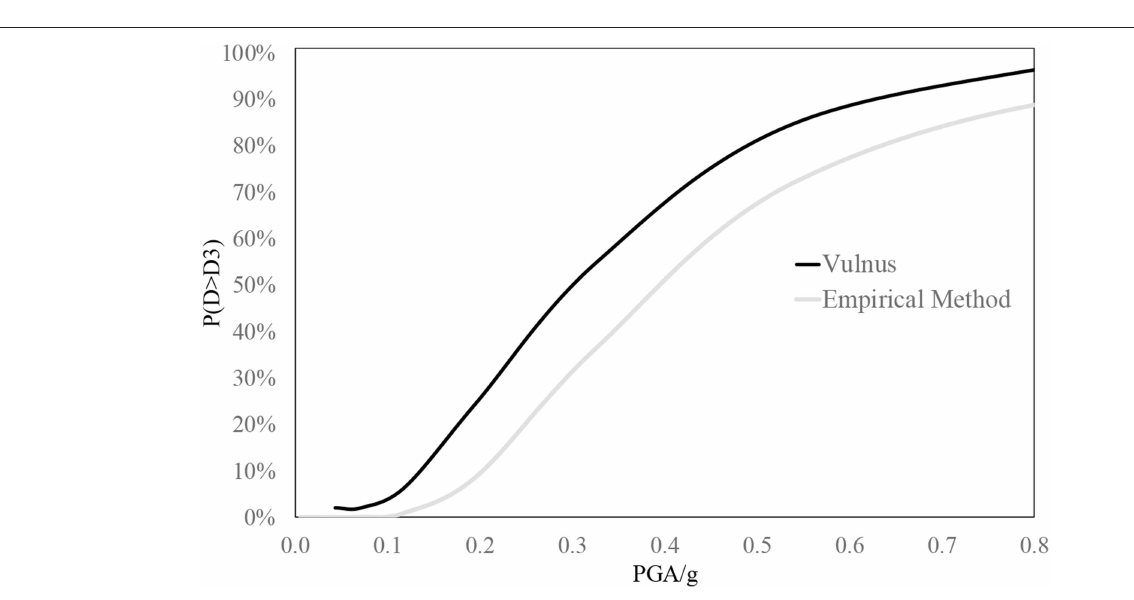
FIGURE 18 | Comparison between the fragility curves given by Vulnus and by the empirical method for a damage grade higher than